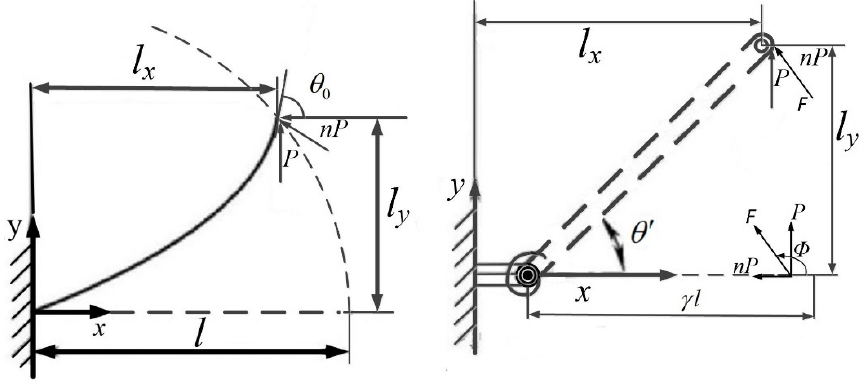
Figure 9. Right flexible finger.